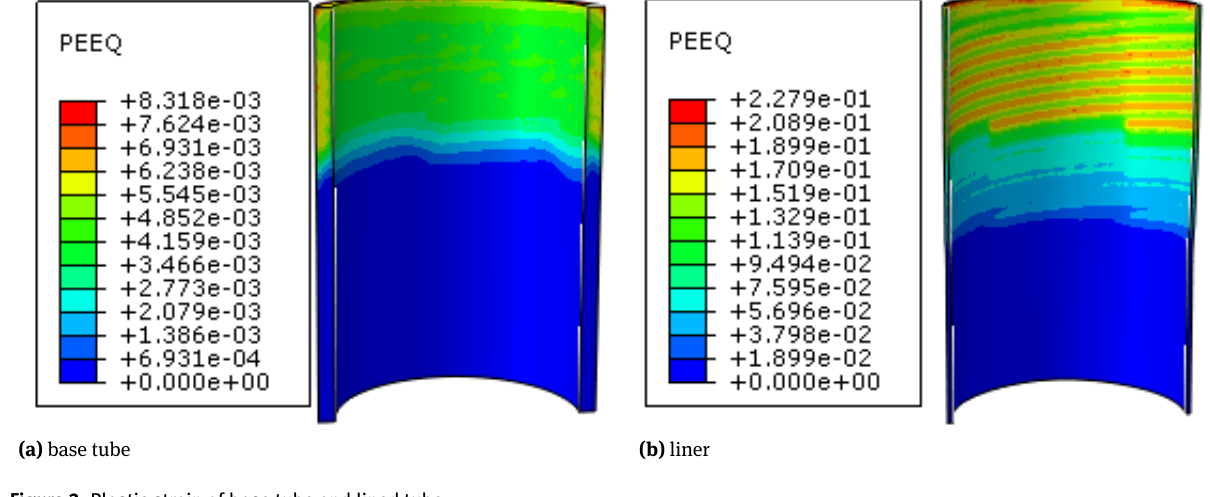
Figure 2: Plastic strain of base tube and lined